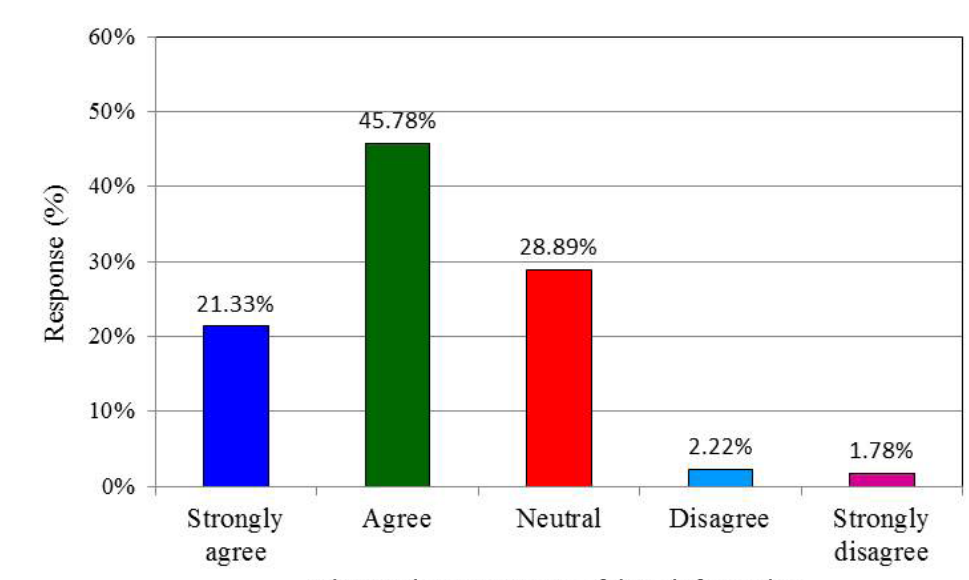
FIGURE 1 - Hospital prescribers’ opinions of the pharmacist as a source of drug information.